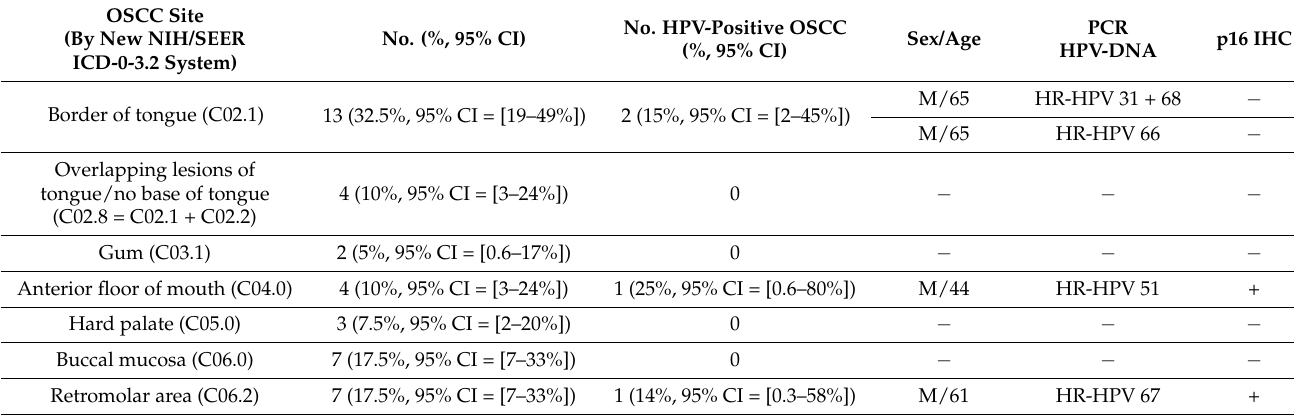
Table 2. HPV frequency in site-coded OSCC.